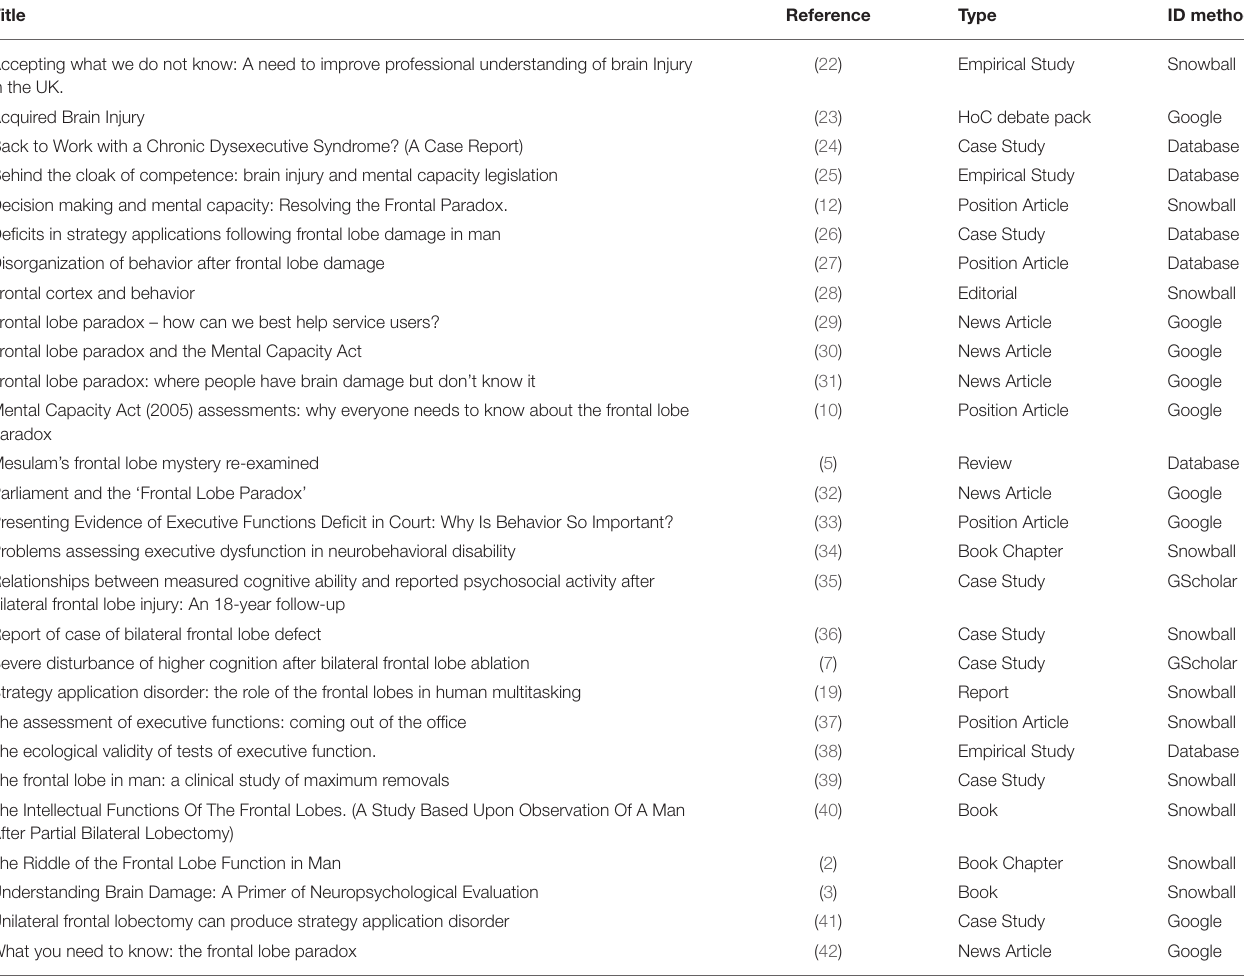
TABLE 2 | Articles identified by database, search engine, and snowball